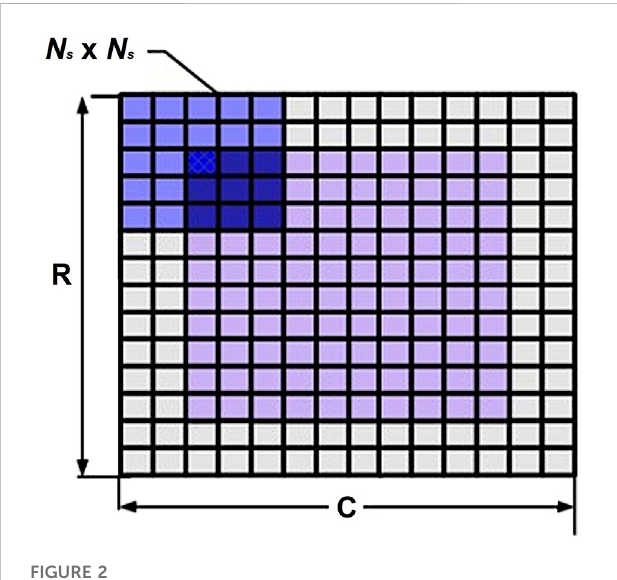
FIGURE 2 Selected window in the measurement